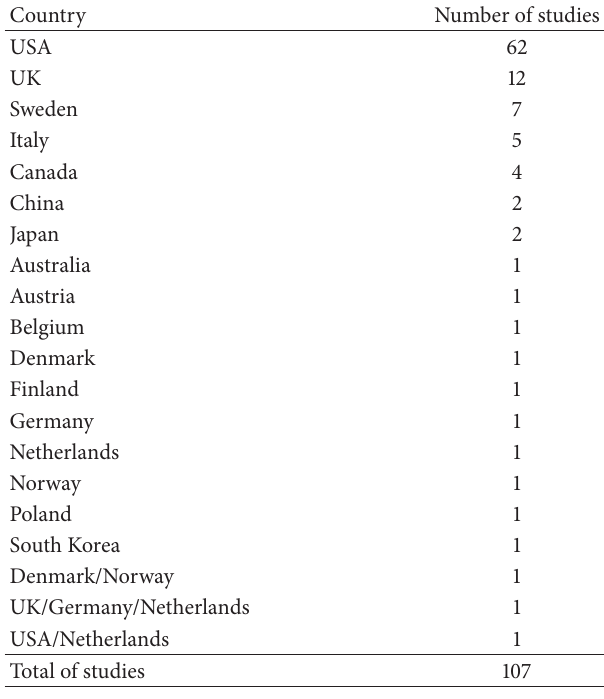
Table 2: Number of studies per country.